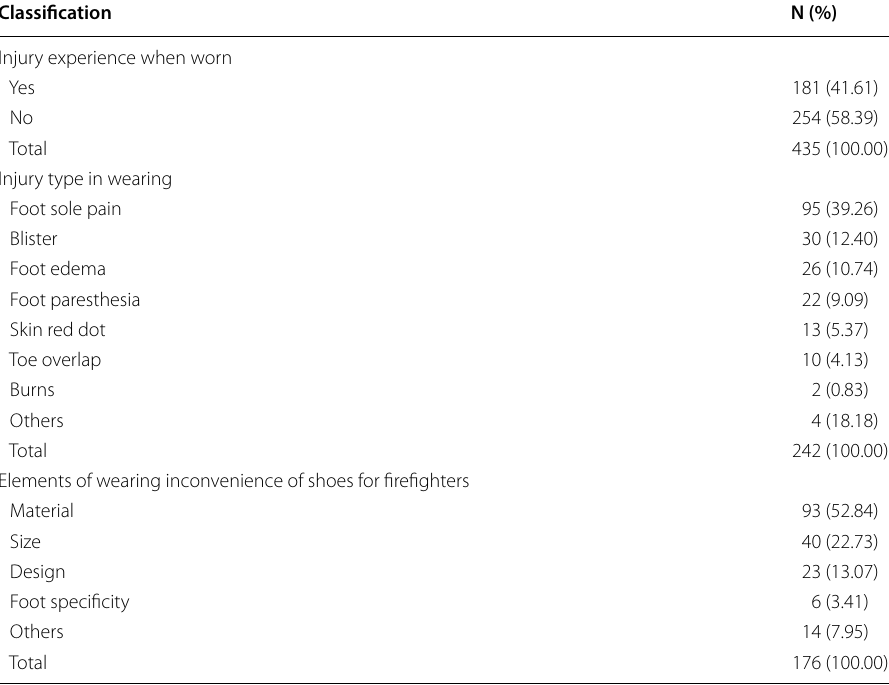
Table 3 Wearing evaluation of protective footwear for firefighters in Korea